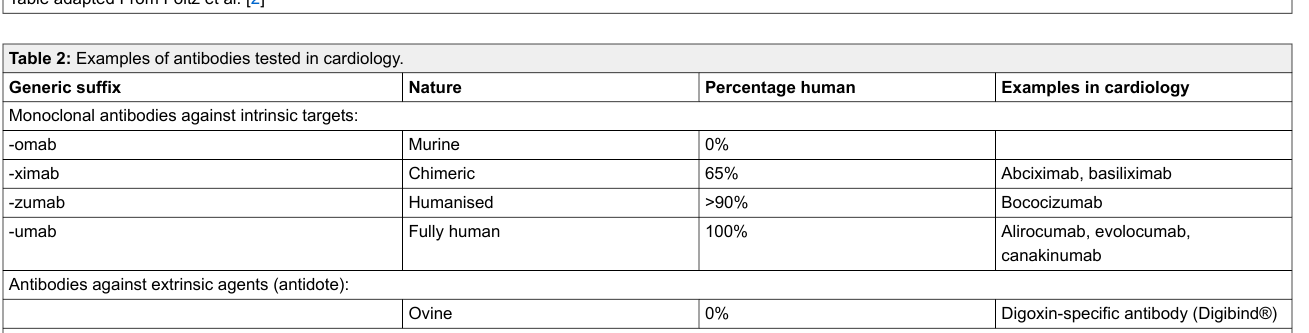
Table adapted From Foltz et al. [2]